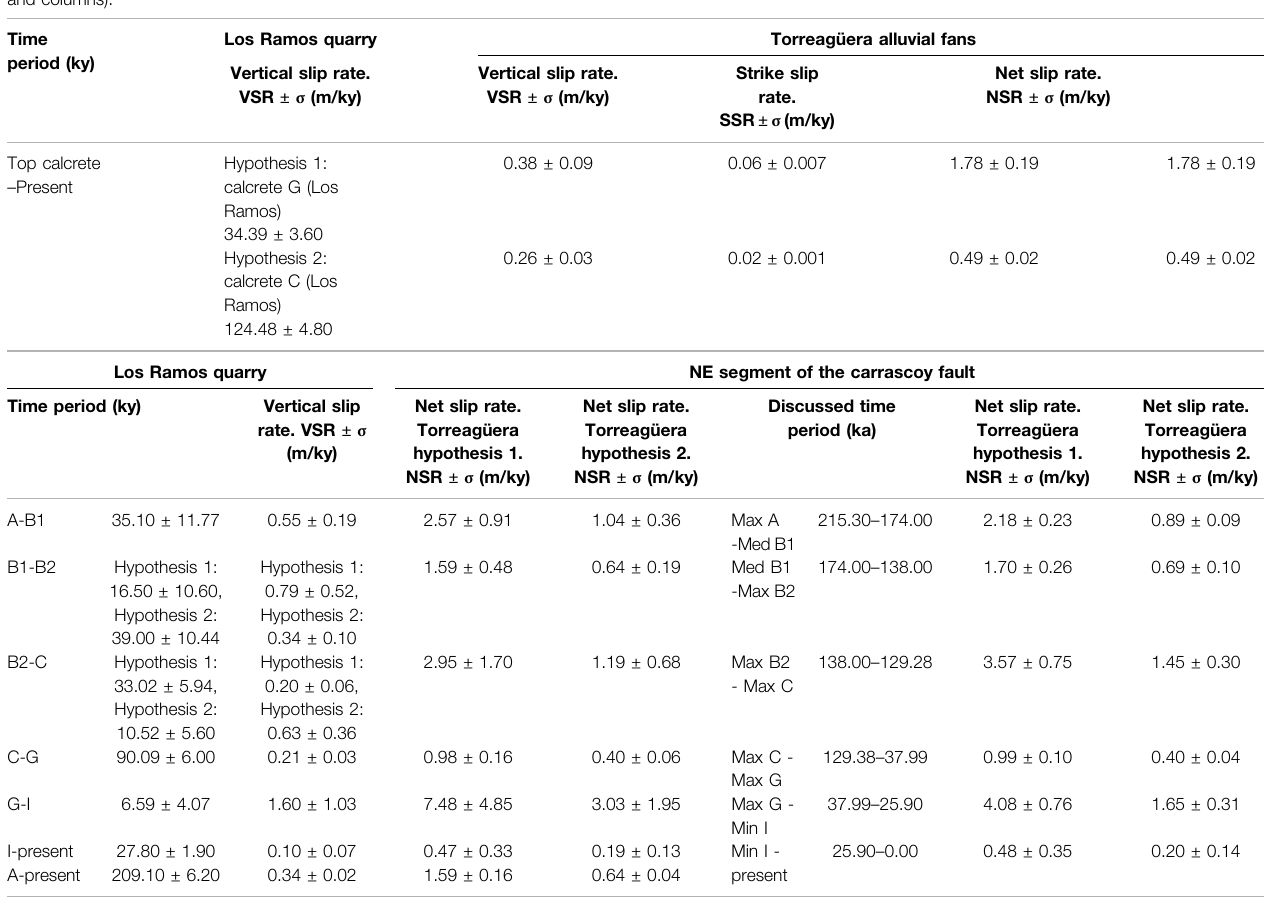
TABLE2| SummaryofthenetslipratesestimatedintheTorreagüeraalluvialfansforthedifferenthypothesisofthetopcalcreteage(hypothesis1:calcreteGandhypothesis 2:calcreteCoftheLosRamosquarry). Verticalslipratesestimated intheLosRamosquarry fortheseperiods.Summaryoftheverticalslipratevariationestimated inthe Los Ramos quarry. Summary of the net slip rate variation calculated for the NE Segment of the Carrascoy Fault based on the two hypothesis of the top calcrete age of the Torreagüera alluvial fans, considering the medium value of the sample ages (black numbers) and the maximum calcrete ages and minimum sediment age (green numbers and